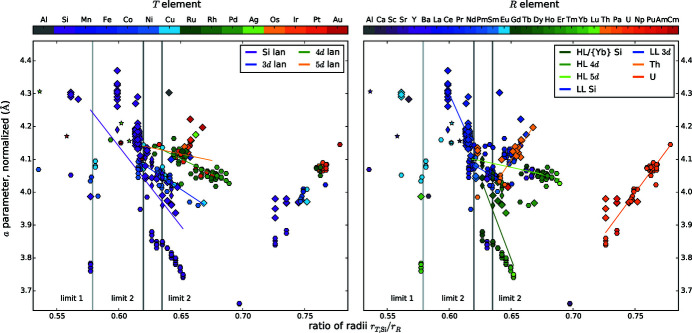
Correlations between lattice parameter a and ratio of radii q
rad. Highlighted are the limit 1 from Mayer et al. (1967 ▸) and our adapted limits 2. The actinide compounds are located in the intermediate area of q
rad between HL and LL compounds, due to the size of their atomic radii.